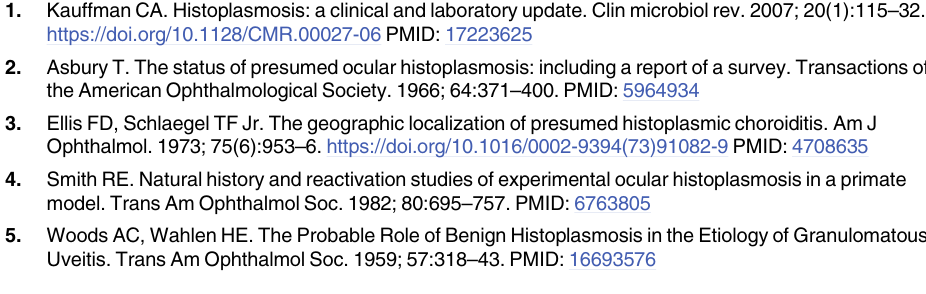
S1 Fig. Rates of herpetic eye disease per 100,000 MarketScan enrollees, 2014. � To avoid unreliable estimates, rates not calculated for states with < 5 cases. Reporting MarketScan data from South Carolina is not permitted. (TIF) S2 Fig. Rates of syphilis retinitis per 100,000 MarketScan enrollees, 2014. � To avoid unreli- able estimates, rates not calculated for states with < 5 cases. Reporting MarketScan data from South Carolina is not permitted. (TIF) S3 Fig. Rates of toxoplasmosis retinitis per 100,000 MarketScan enrollees, 2014. � To avoid unreliable estimates, rates not calculated for states with < 5 cases. Reporting MarketScan data from South Carolina is not permitted.